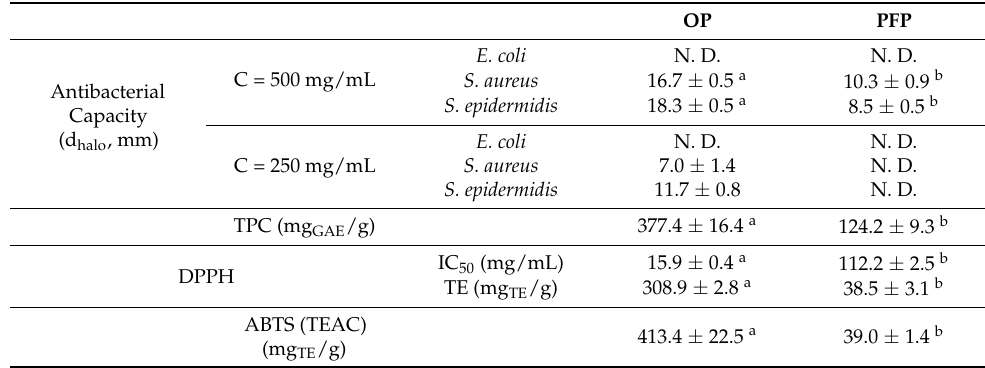
Table 1. Obtained results in the characterization of the biological capacity of the onion peel and passion fruit peel extracts.